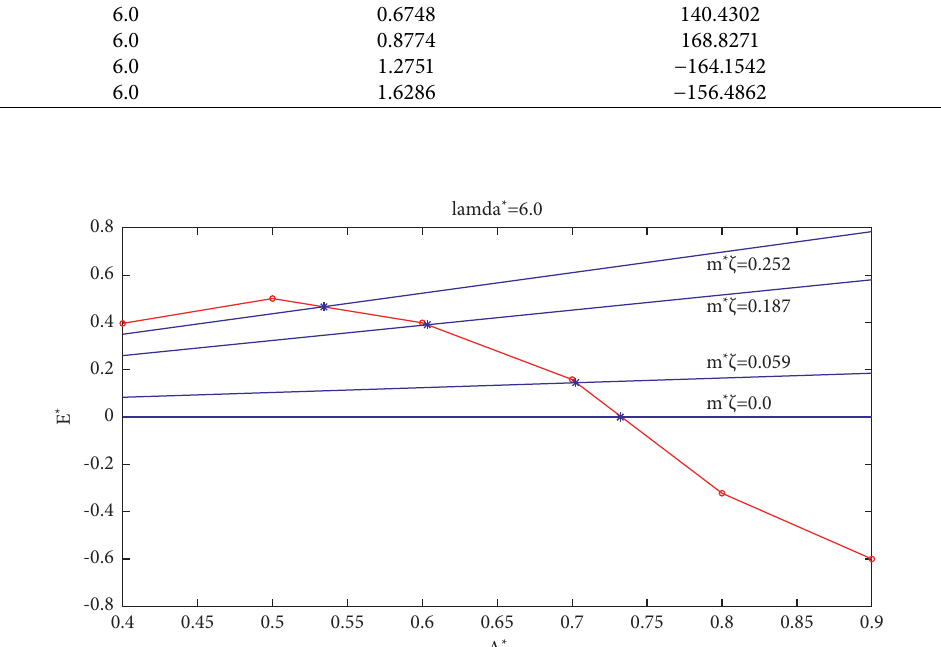
Figure 14: Prediction of amplitude response A ∗ at different mass damping when λ ∗ � 6 .